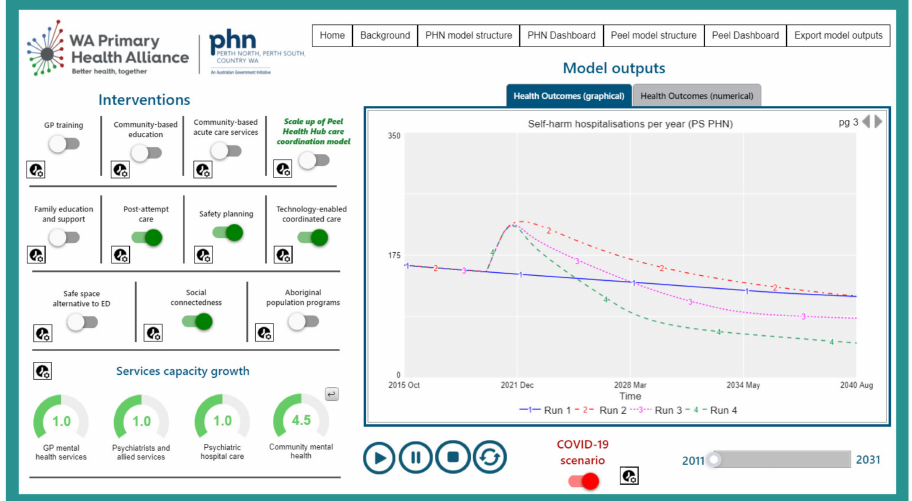
Figure 2. Interactive model